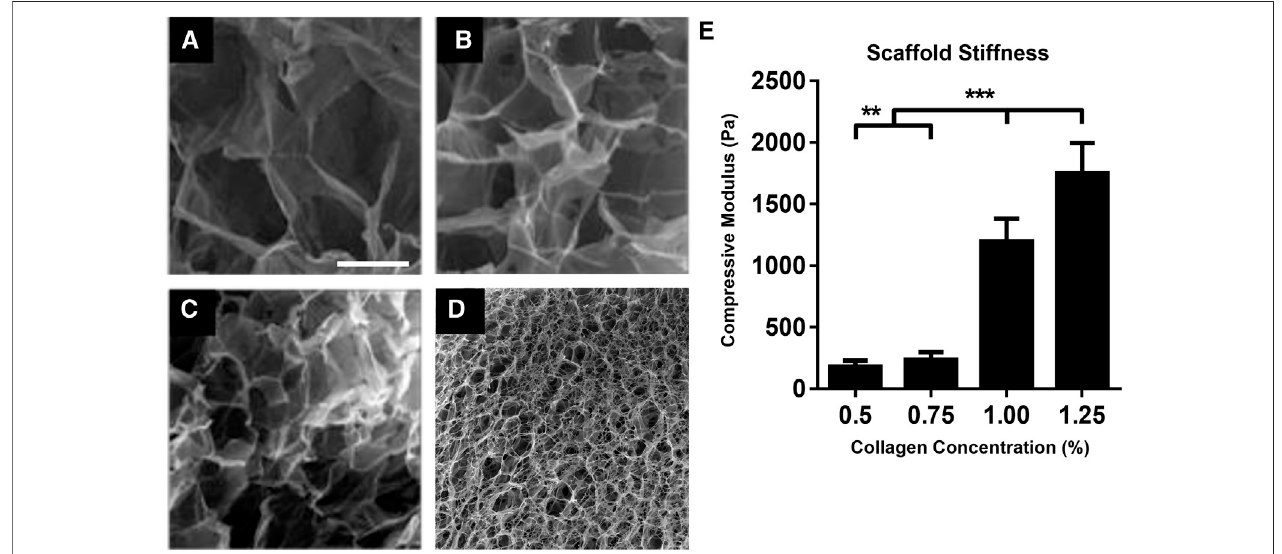
FIGURE1| Collagenconcentrationgovernsmicroarchitectureandmechanicsofscaffolds.SEMmicrographsofporousColscaffoldsfabricated via ice-templating at − 10 ° C using 0.5 wt% (A) , 0.75 wt% (B) , 1.0 wt% (C) and 1.25 wt% (D) Col concentrations. Compressive modulus of corresponding Col scaffolds, as measured via DMA (E) . ** p < .01, *** p < .001, Mean ± SD. Scale bar = 100 μ m.